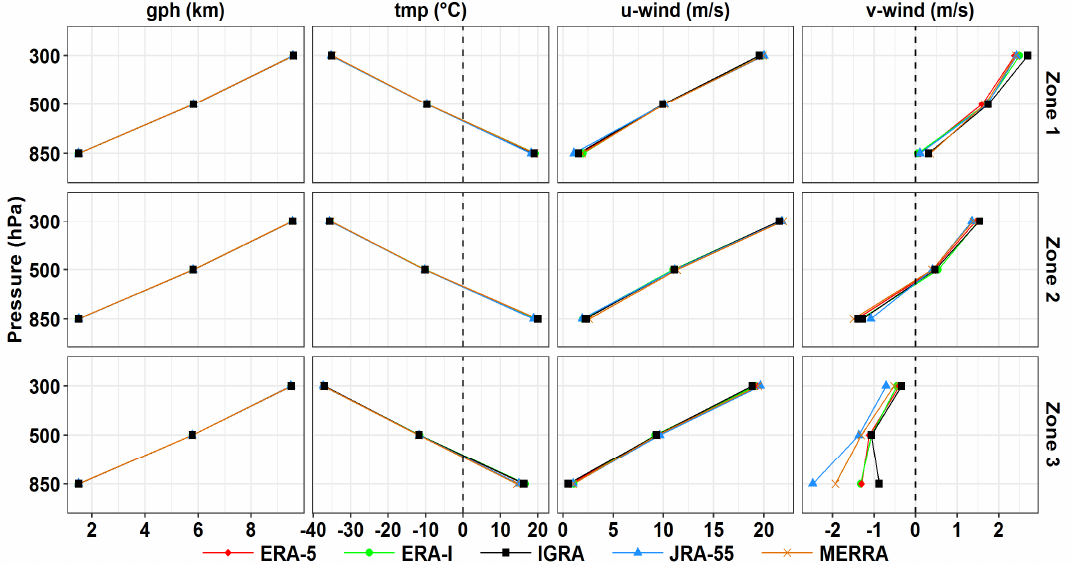
Figure 2. Annual mean vertical profiles of geopotential height (gph), air temperature (tmp) and horizontal wind averaged over soundings, along with means from the four reanalysis products.